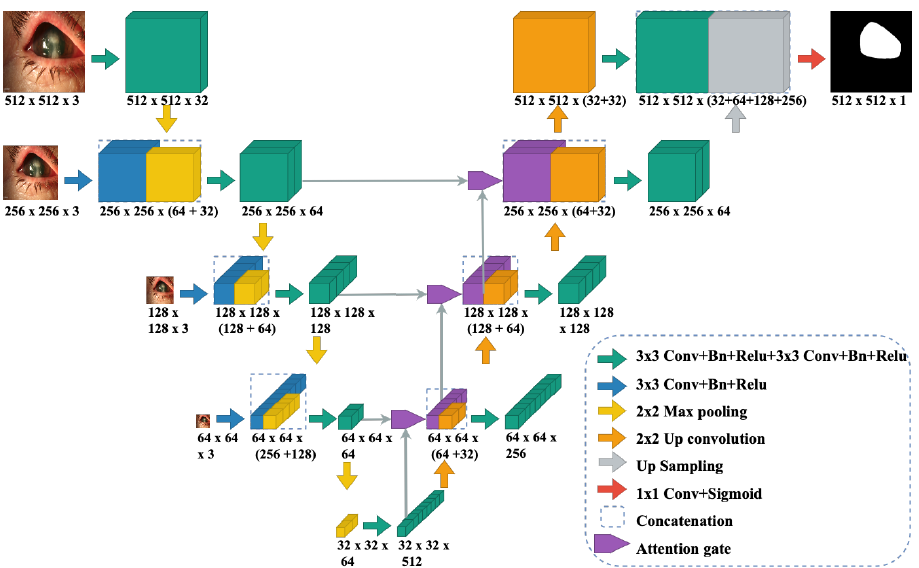
Figure 2. MS-CNN architecture used for corneal RoI